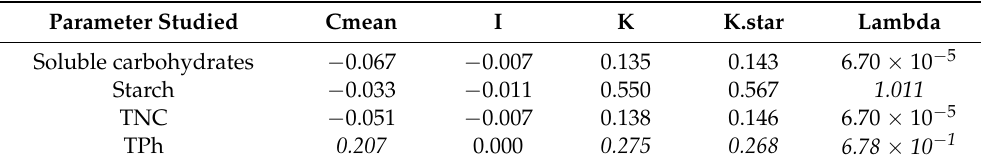
Table 2. Phylogenetic signals of the soluble carbohydrates, starch, TNC, and TPh represented by the C mean, I, Blomberg’s K, K.star, and Lambda phylogenetic correlation coefficients. Statistically significant coefficient values are italicized.